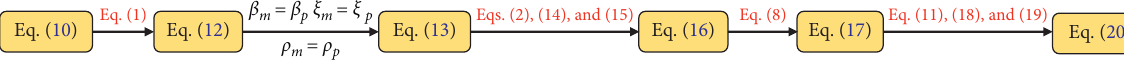
Figure 3: The flow diagram of formula derivation.